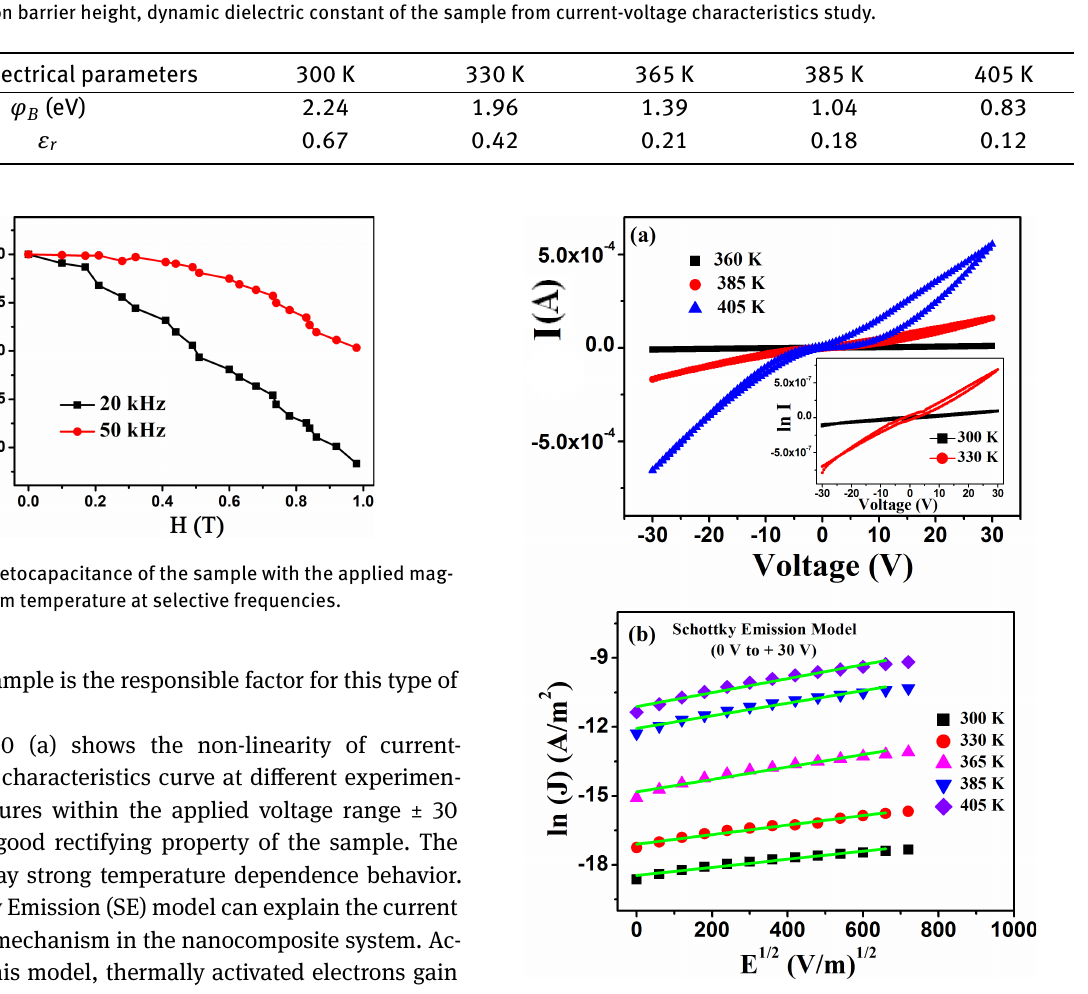
Figure 10: (a) I vs. V curves of the sample at different temperatures, (b) ln J vs. E 1/2 plots at different temperatures.